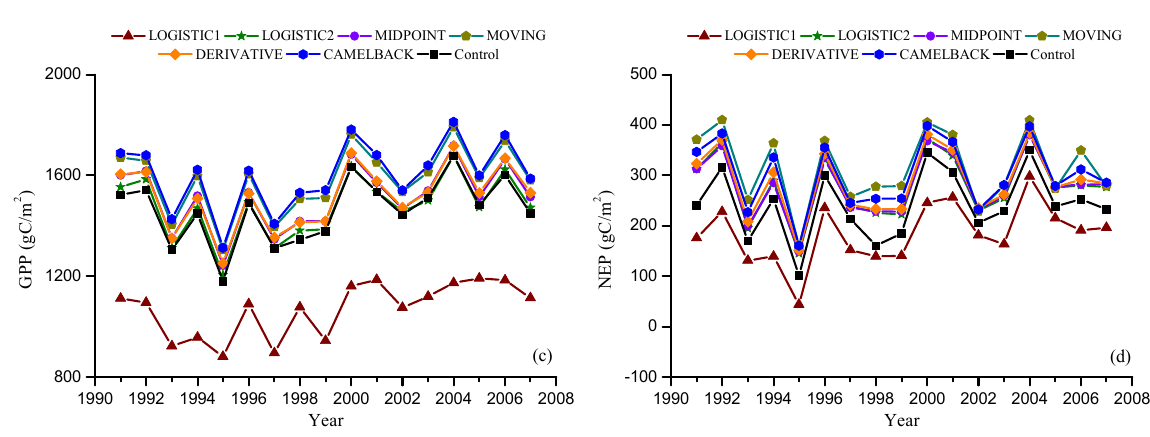
Figure 7. Relationship between errors in phenology and errors in simulated productivities. Leaf onset vs. GPP ( a ); leaf onset vs. NEP ( b ); leaf offset vs. GPP ( c ) and leaf offset vs. NEP ( d ). Regressions were conducted using all data in the same category of simulations. P -Value for all regressions is less than 0.01. Symbols indicate the phenology method used. For example, “NDVI LOGISTIC1” in (a) indicates that the leaf onset dates were modeled using the “Sequential” model and the parameters were optimized with onset dates derived from NDVI using method